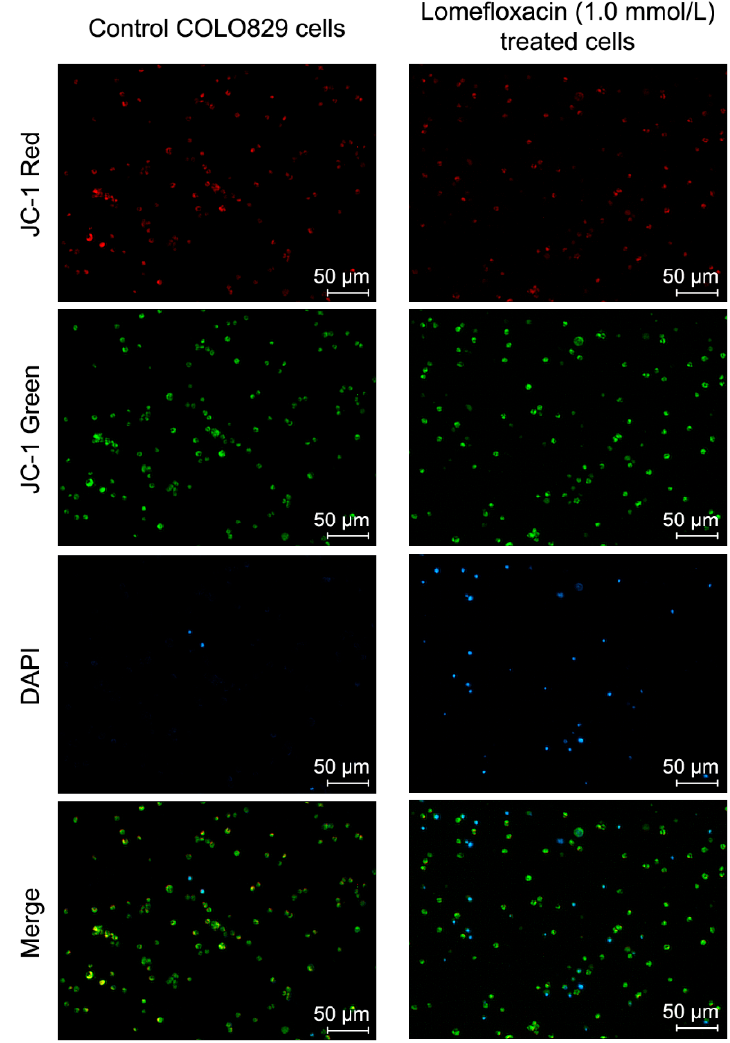
Figure 8. Lomefloxacin induces changes in cellular red and green (JC-1) or blue (DAPI) fluorescence intensity as a result of apoptosis induction in COLO829 cells. The cells were treated with lomefloxacin at a concentration of 1.0 mmol/L for 24 h. The cells were observed under a fluorescence image cytometer (scale bar 50 µm). Q1ur—mitochondrial membrane polarized cells; Q1lr—mitochondrial membrane depolarized/apoptotic cells; M1—DAPI-positive/late apoptotic cells.